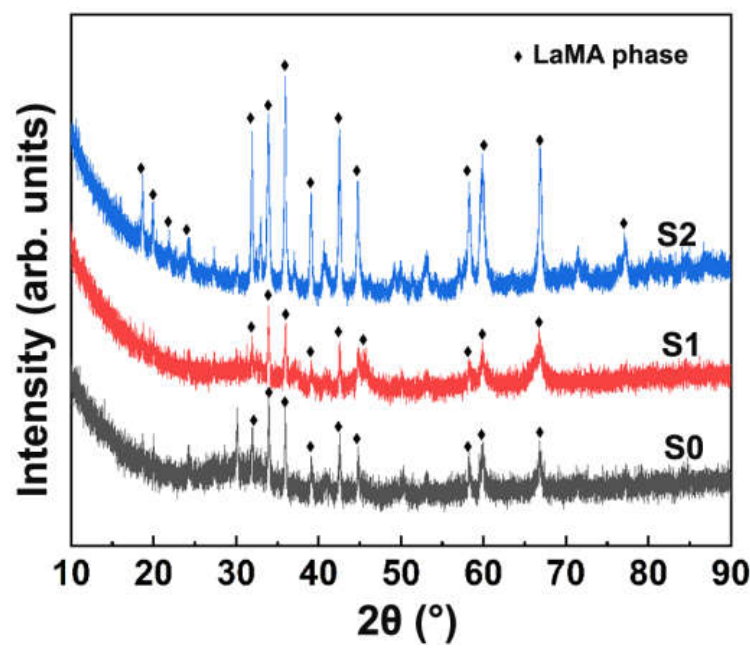
Figure 1. XRD patterns of the sprayed and annealed coatings.